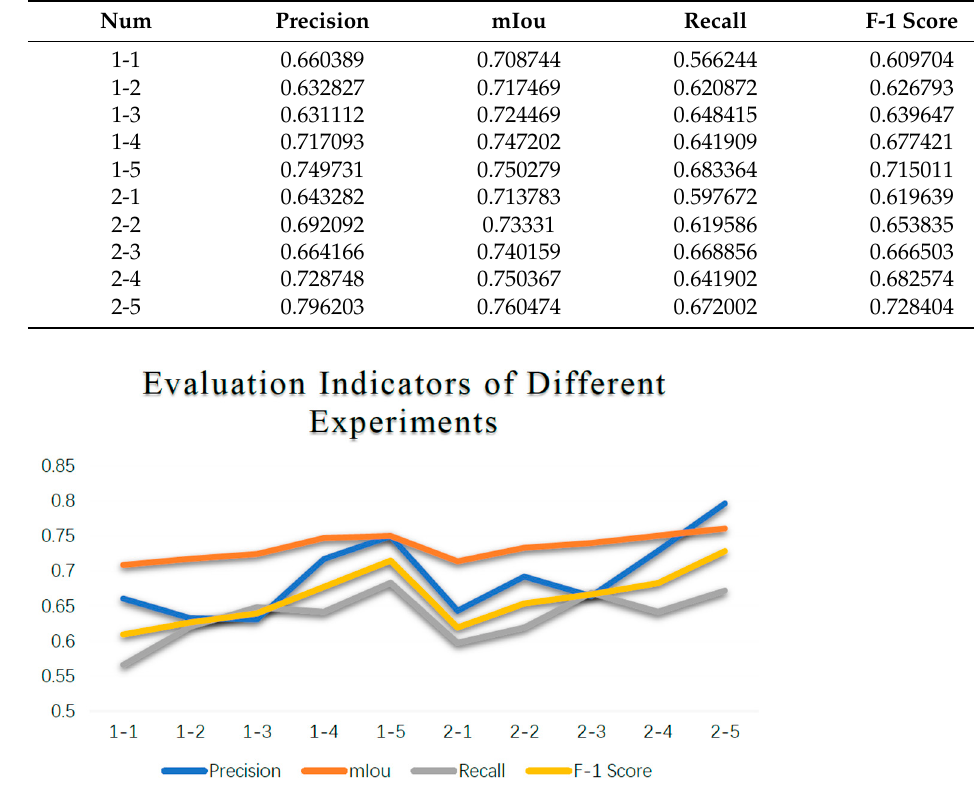
Table 4. Evaluation indicators of different experiments.